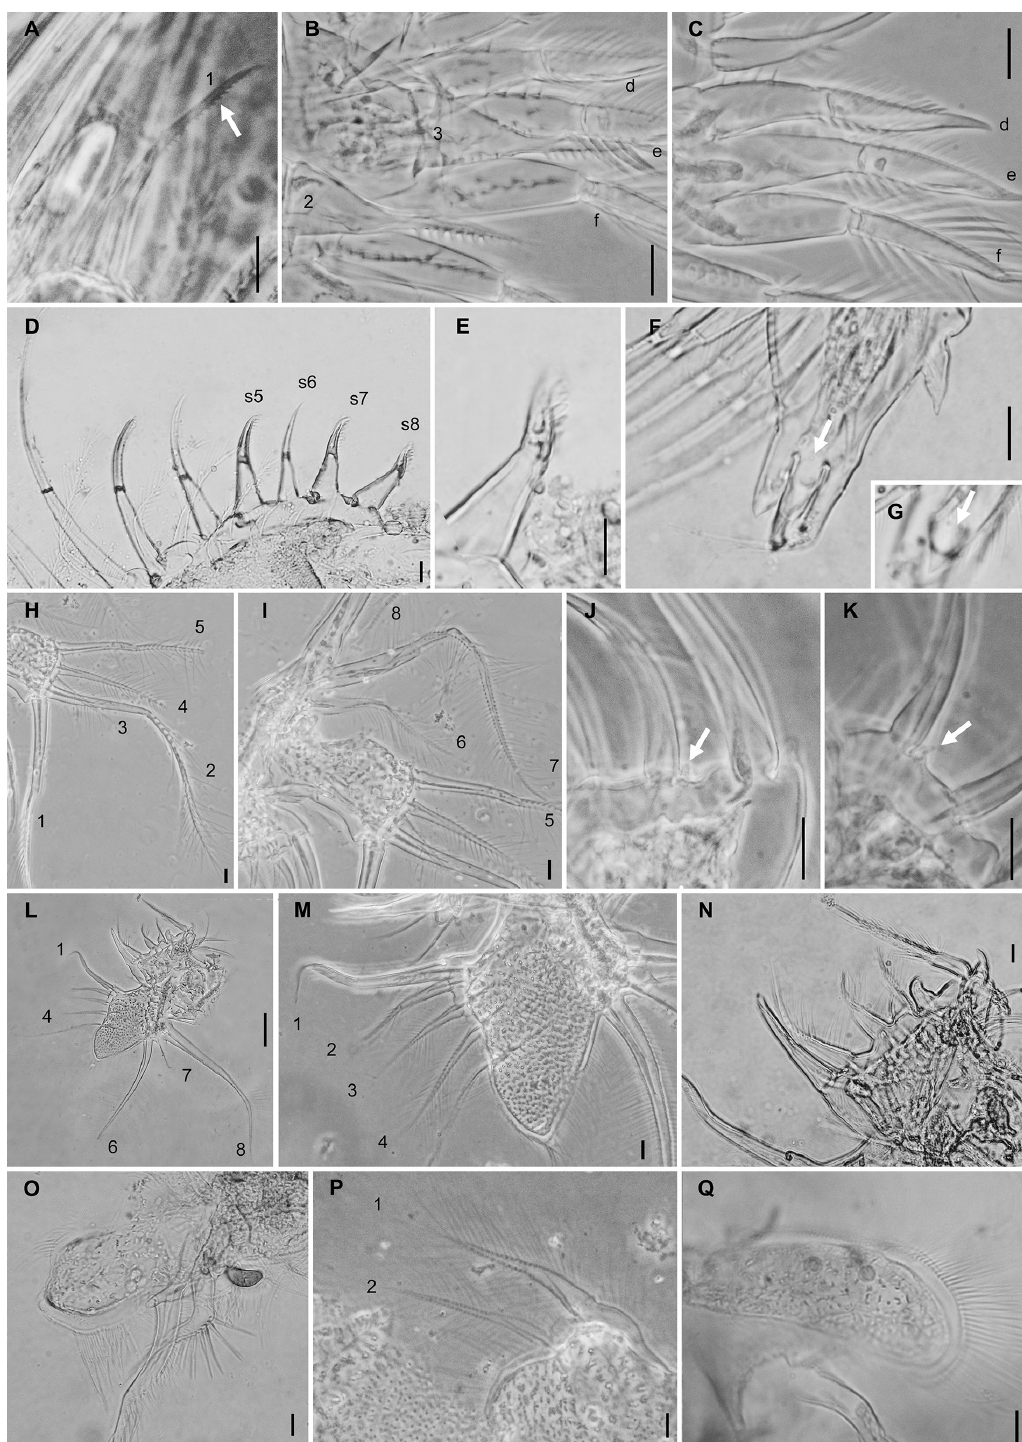
Fig. 7. Acantholeberis accolismaris Sousa, Elmoor-Loureiro & Álvarez-Silva sp. nov., parthenogenetic female from Jurubatiba National Park. A–C . First limb. A. Stiff seta on first endite. B. Stiff setae on second and third endites. C. Setae d–f on endite 2. D–G . Second limb. D. Partial view of the endite. E.